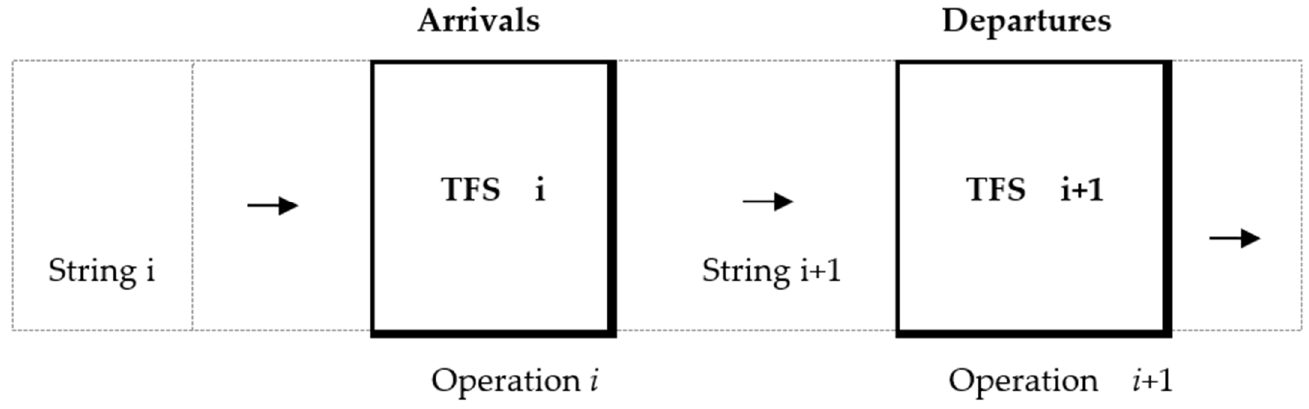
Figure 2. The flow-based processing.